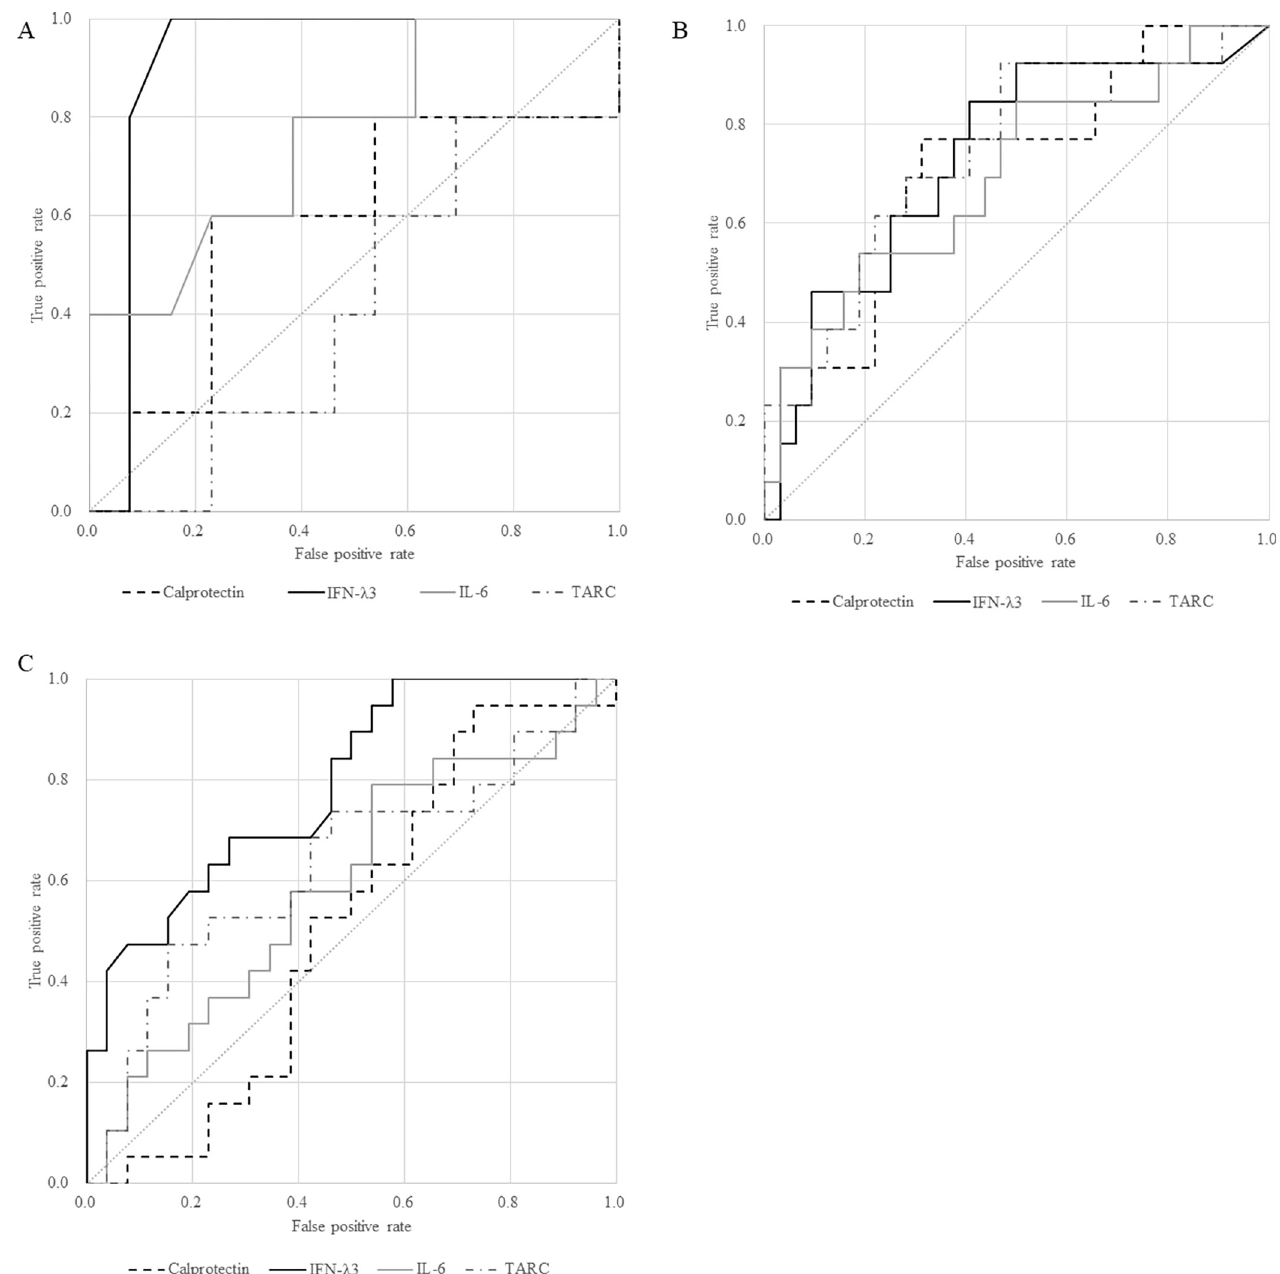
Fig 3. Comparison of the predictive ability of biomarkers for disease severity in hospitalized individuals with a COVID-19 diagnosis. A: Predictive ability for future oxygen administration in patients within 8 days after symptom onset, who did not require oxygen supply at the time of serum collection (Study 1). B: Predictive ability for future mechanical ventilation administration or death in patients with oxygen support except mechanical ventilation within 4 days after starting the oxygen supply (Study 2). C: Predictive ability for future oxygen support by a nasal high-flow cannula, non-invasive positive pressure ventilation, or mechanical ventilation in patients with oxygen support by a nasal canula or mask within 4 days after starting the oxygen supply (Study 2). Using the scoring of the number of biomarkers positive at the cutoff calculated by the ROC curve for IL-6, IFN- λ 3, TARC, and CP, predicting future mechanical ventilation demand was evaluated to have an AUC of 0.86 (95% CI: 0.75–0.97). When two or more biomarkers were positive, the results were better: 0.92 sensitivity (95% CI: 0.64–1.00), 0.63 specificity (95% CI: